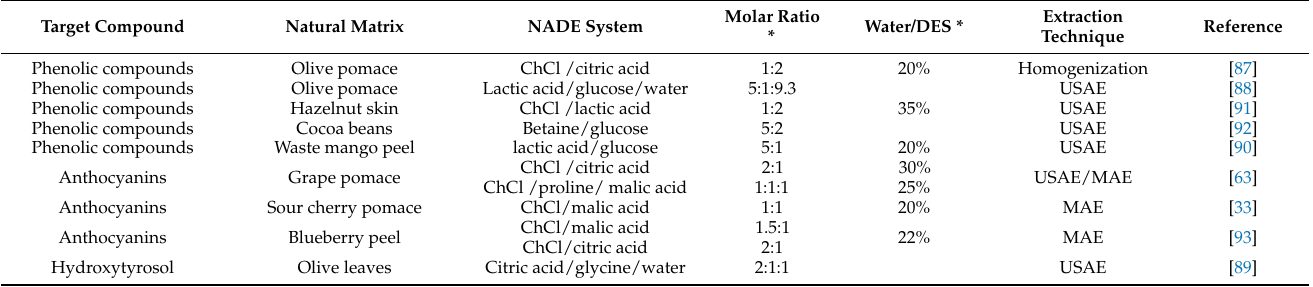
Table 3. Extraction of target compounds from food wastes by using NADES and combined extraction